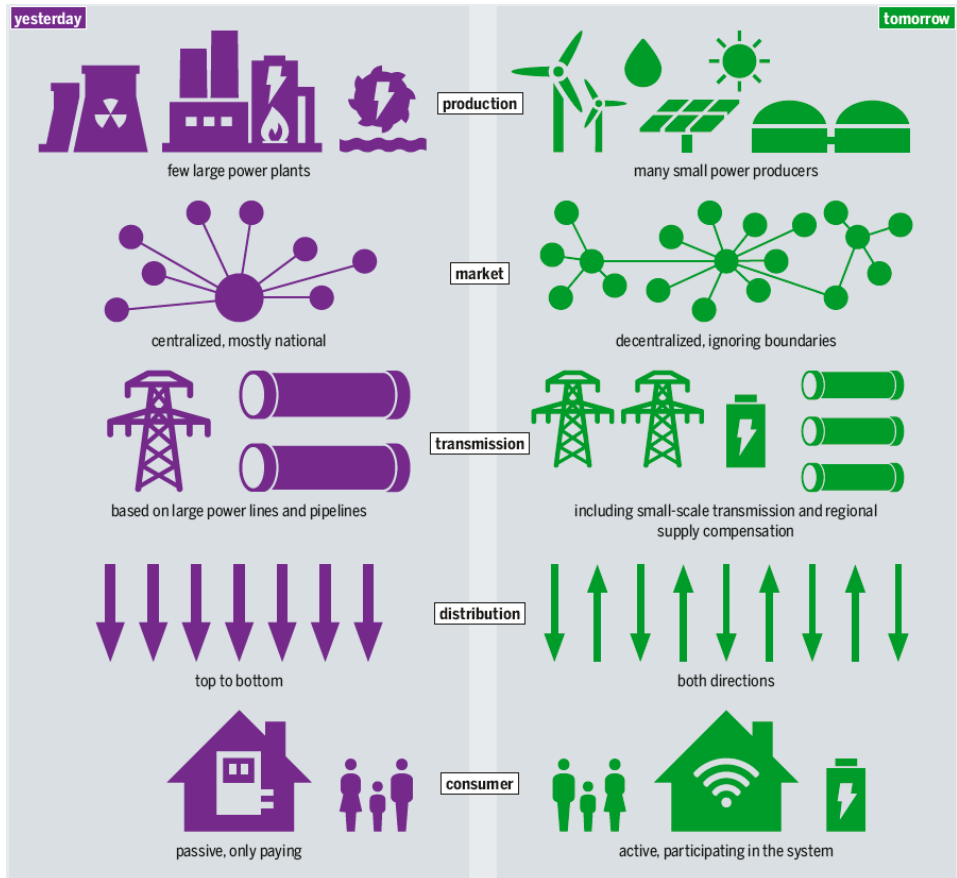
Figure 1. Comparison of the current power network with the smart grid [5].